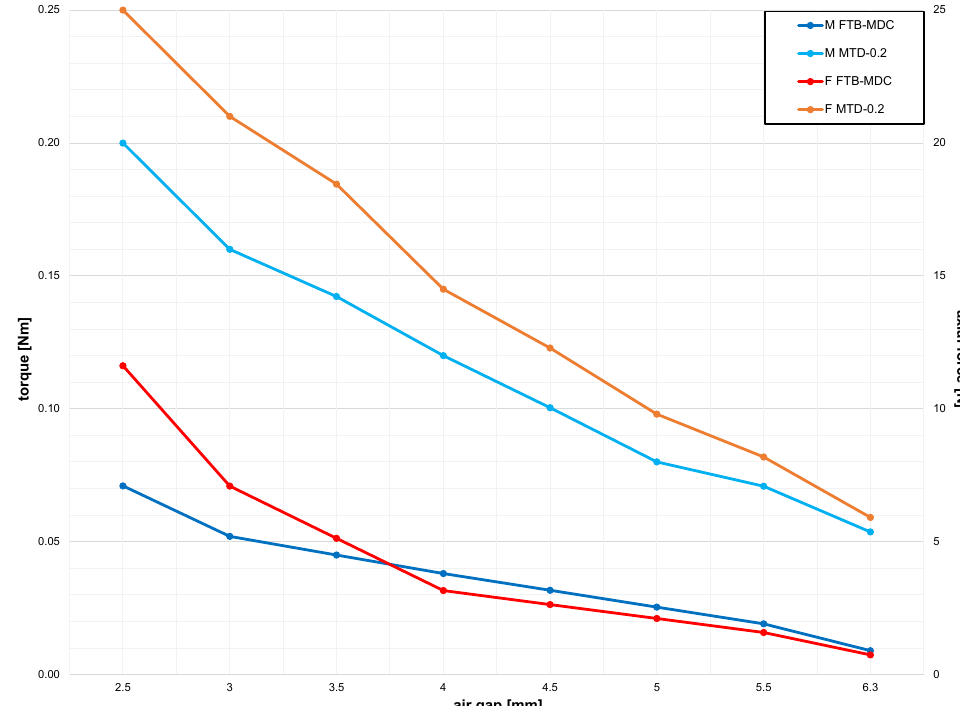
Figure 11. FTB–comparison magnet disc coupling torque and axial force, adapted to